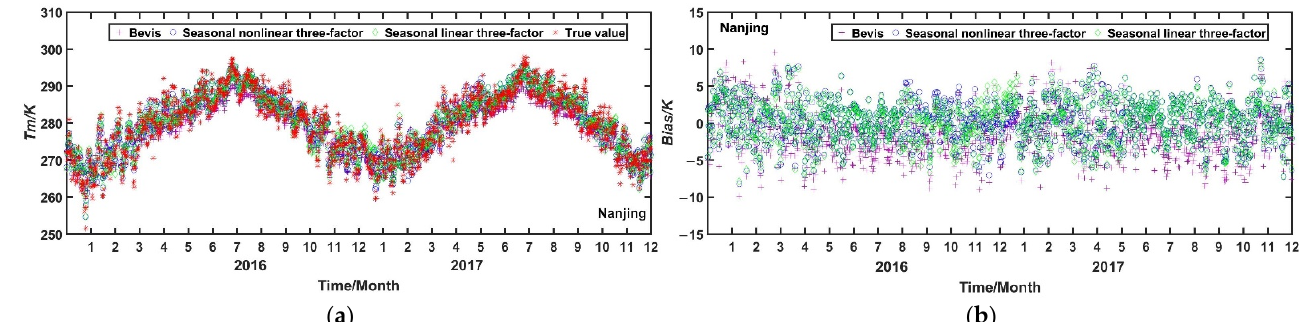
Figure 10. Time series of T m ( a ) and the biases ( b ) of Bevis, linear and nonlinear seasonal three-factor RTMs to the radiosonde-derived 𝑇 (cid:3040) at Nanjing station during 2016–2017.